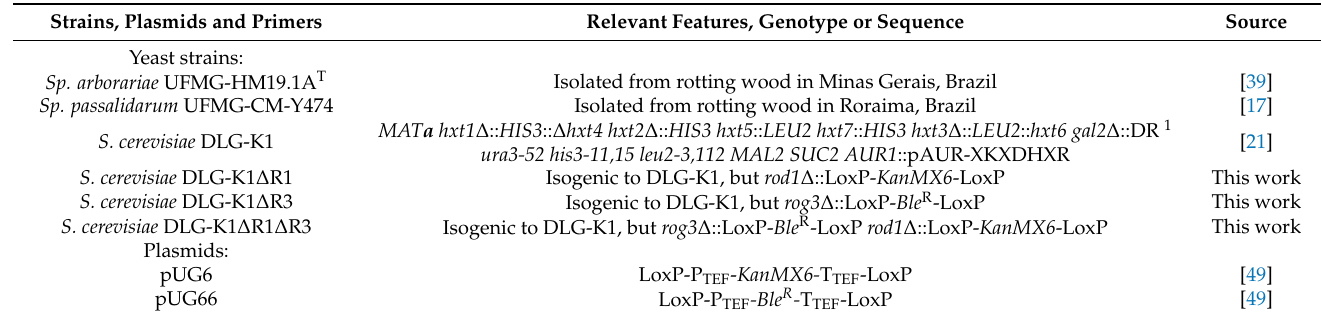
Table 1. Yeast strains, plasmids and primers used in this